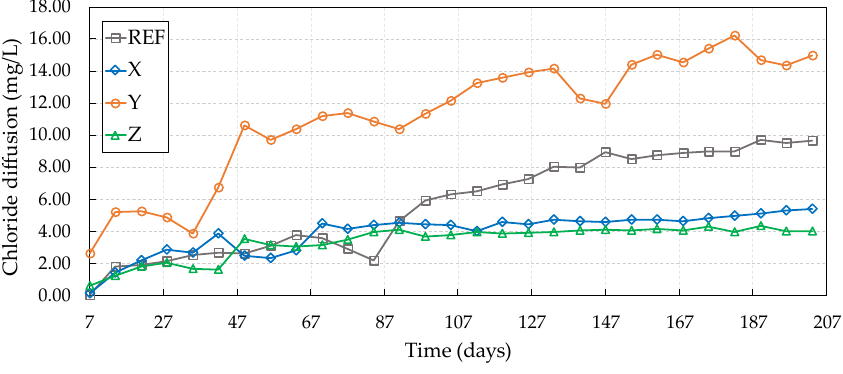
Figure 9. Chloride diffusion after two wet–dry cycles.